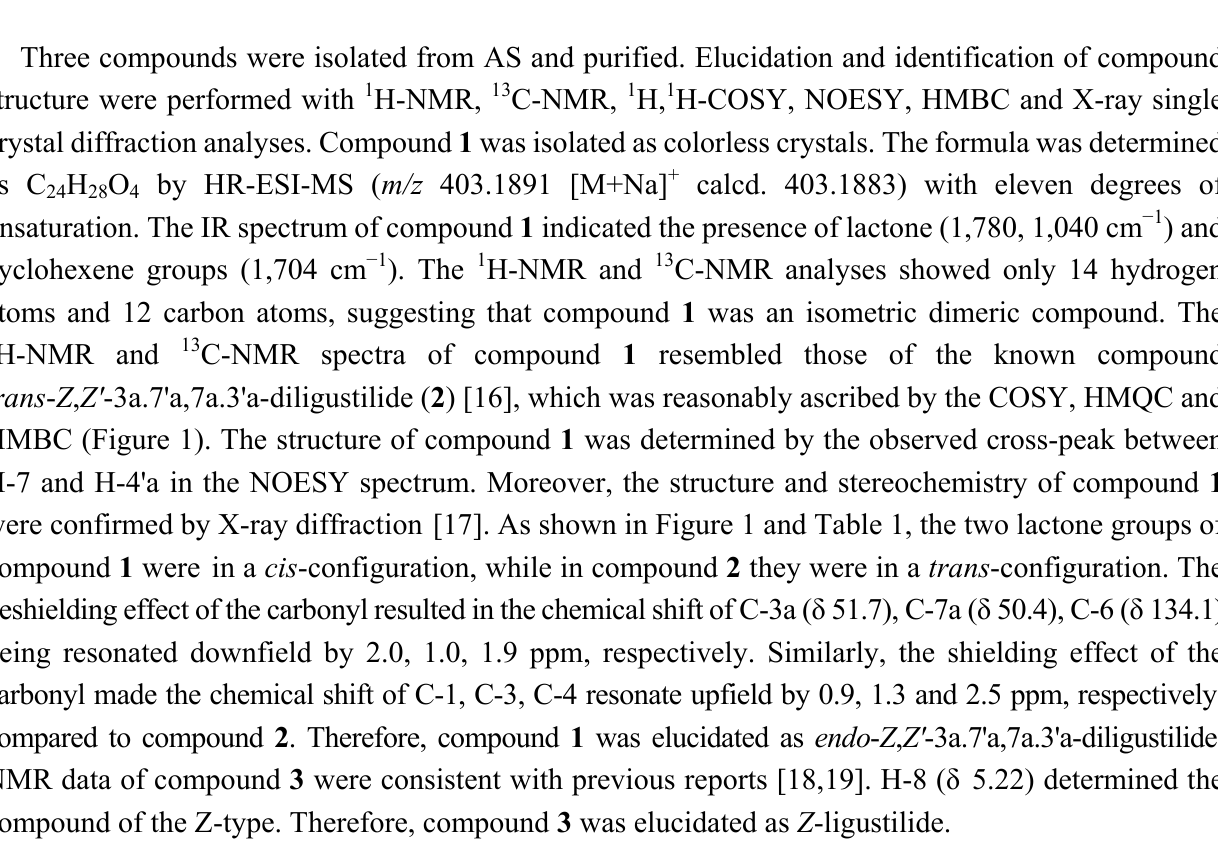
Figure 1. Postulated biosynthetic pathways of compounds 1 and 2 , X-ray crystal structure and key NOESY correlations of compound 1